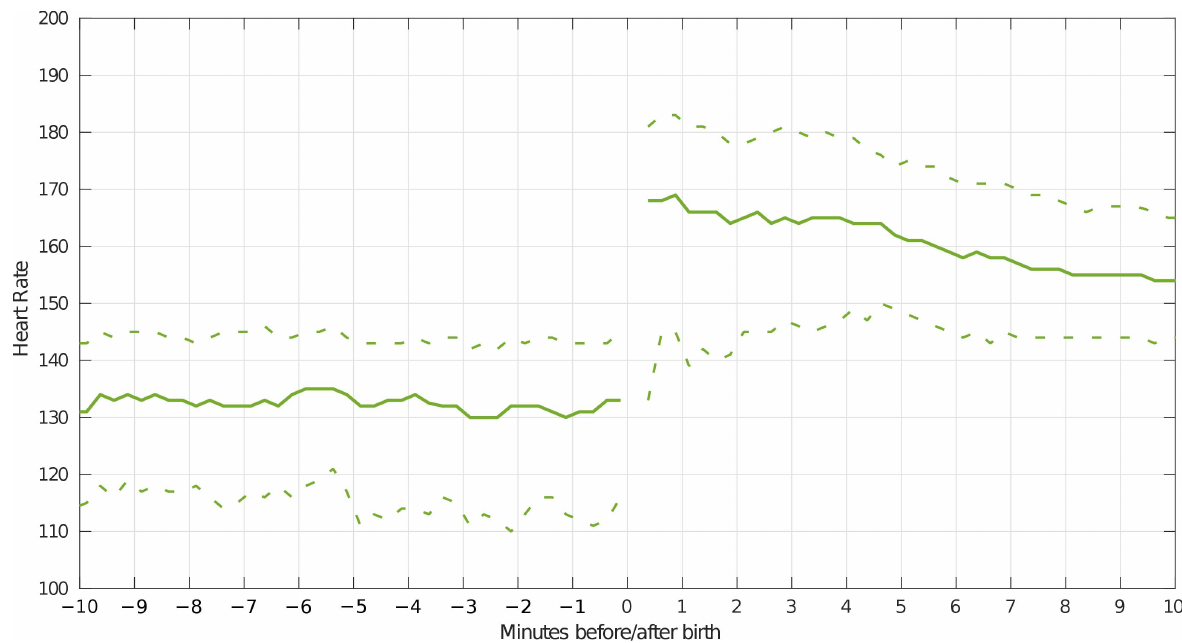
Figure 3. Illustration of heart rate transition 10 min before and after delivery. The solid line shows the median heart rate, and the dashed lines show the 25th and 75th percentiles. Each point on the curves indicates the median and percentile for a 15 s time segment.